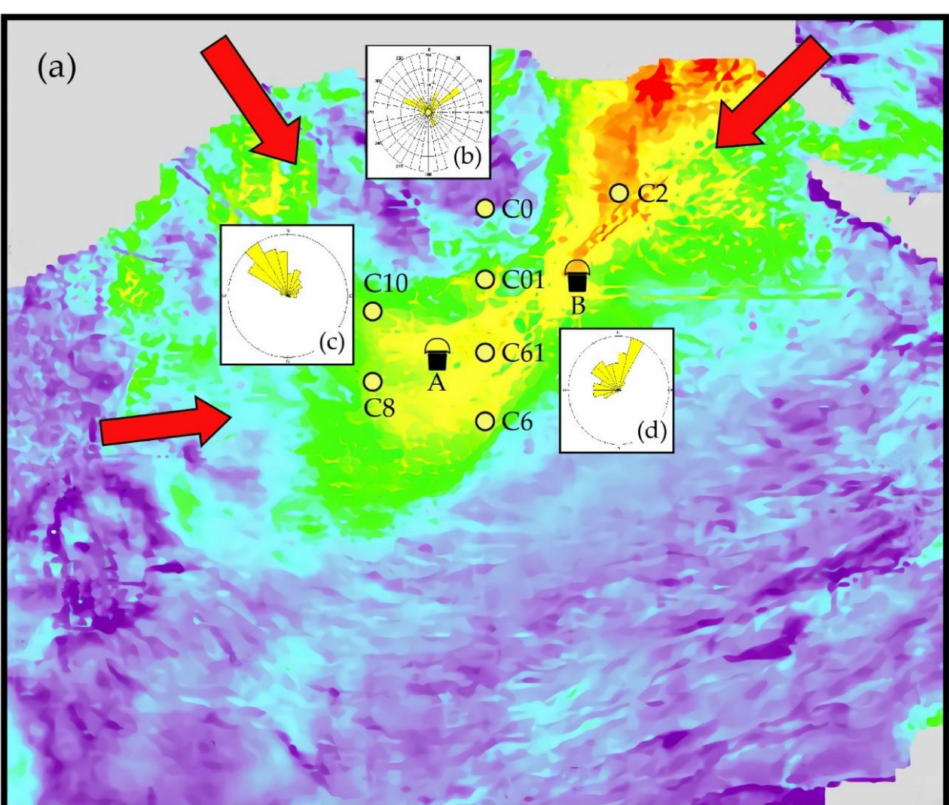
Figure 8. ( a ) Cumulative seismic amplitude map. Blue to red indicates the velocity of seismic waves from fast to slow. Red arrows indicate the directions of paleocurrents. A and B indicate the predicted high-quality liquid reservoirs (presented as buckets). ( b – d ) The paleocurrents implied by the results of stratigraphic dip logging of Wells C10, C01, and C61 are presented in rose